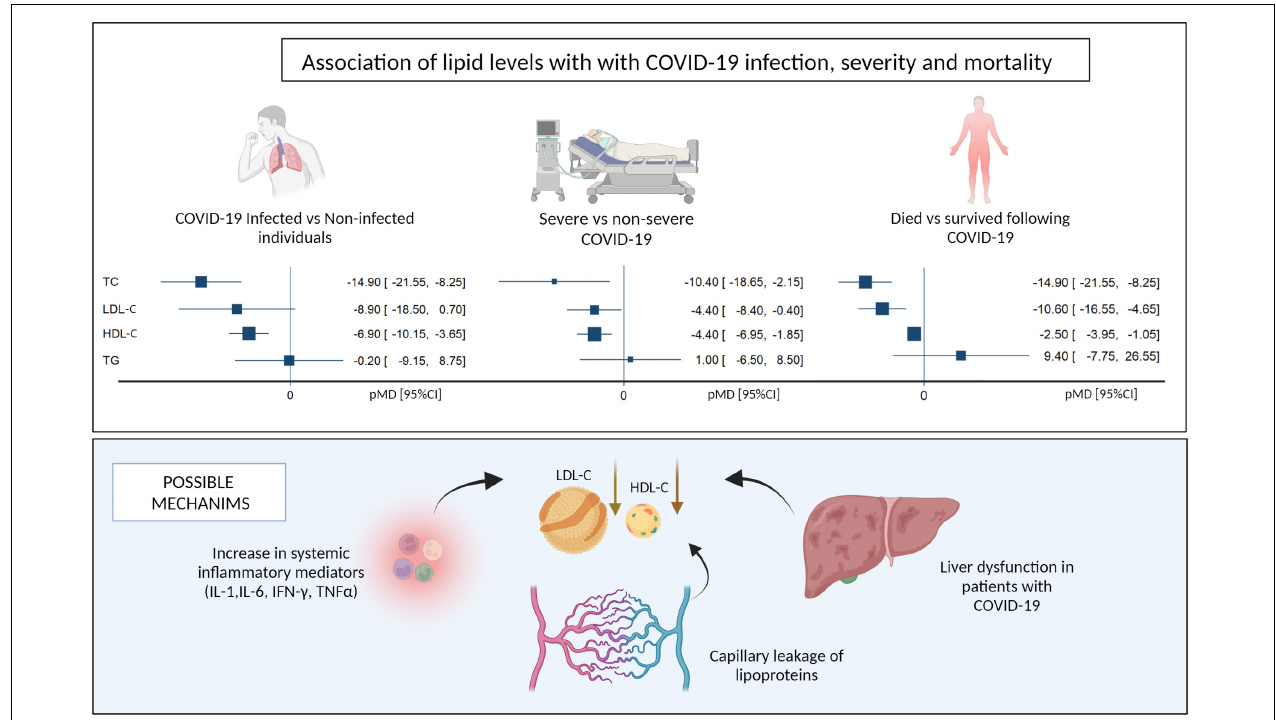
FIGURE 4 | Summary of pooled mean differences and possible mechanisms for the association of lipid levels with COVID-19 infection, disease severity and mortality. LDL-C, Low density Lipoprotein, HDL-C, High Density Lipoprotein (Created with